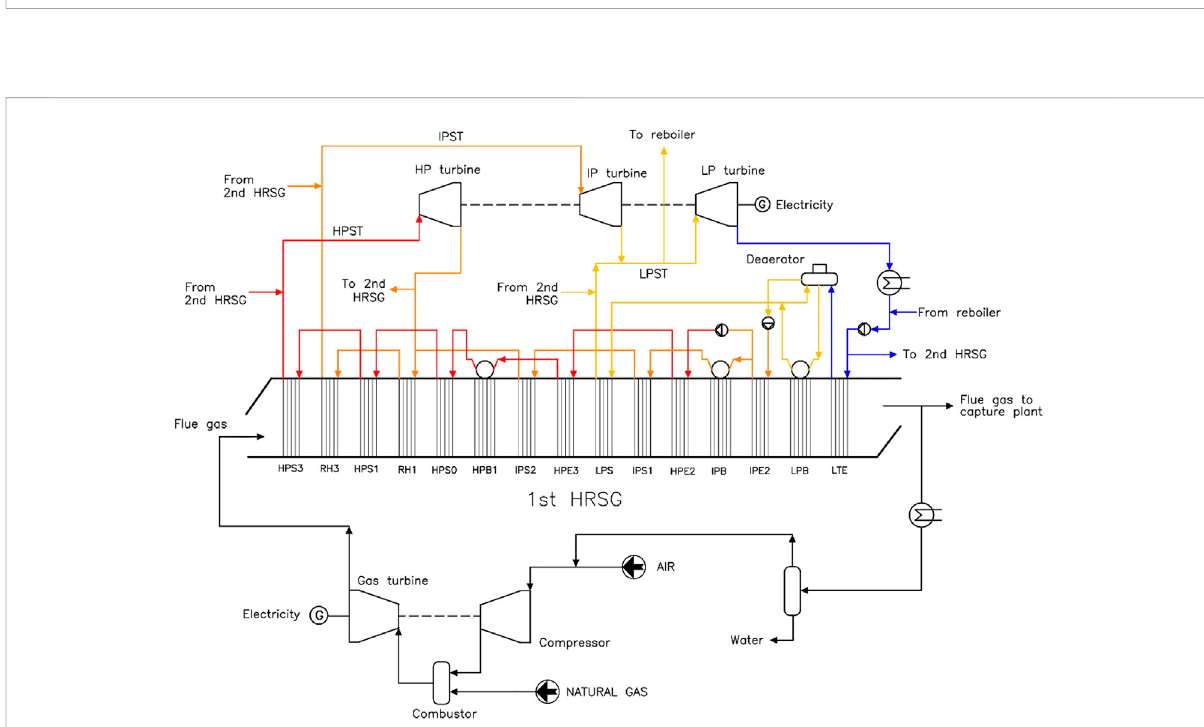
FIGURE 2 Exhaust Gas Recirculation combined cycle. Extracted from (Díaz-Herrera et al.,